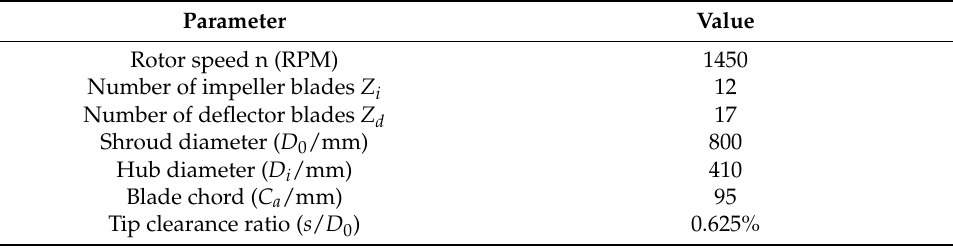
( b ) Figure 2. Axial flow fan blade modeling method: ( a ) 3D impeller model and the position of θ and β ; ( b ) the radial distribution of θ and β . The radial distribution of θ and β is composed of standard ‐ form rational quadratic Bézier curves [11,12]. The position of the three control points determines the shape of each curve. Figure 2b shows the radial distribution curves of θ and β along the spanwise direc ‐ tion. The distribution curves are created by the second ‐ order rational Bézier curve, whose shape is determined by three control points. Taking the distribution of θ as an example, the x ‐ coordinate of control points P 1 and P 3 represent the θ at spans 0 and 1. The camber of the θ distribution curve ( A) , which is determined by the position of point P 2 , is defined as follows: